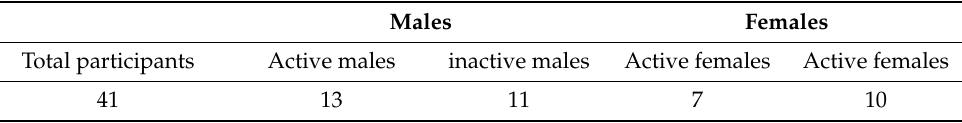
Table 1. The breakdown of participants by gender and